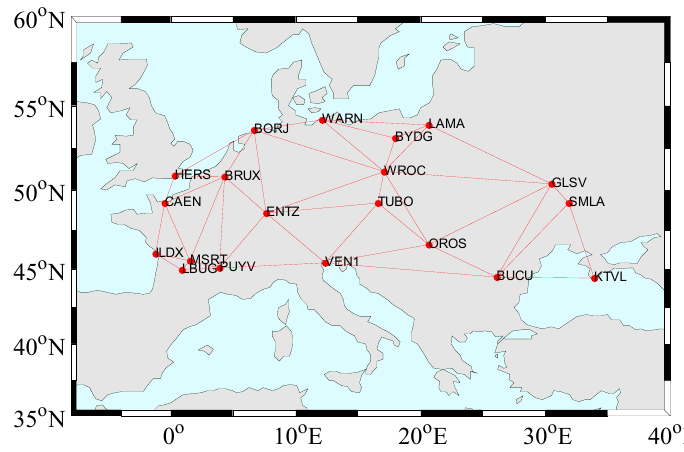
Figure 1. Distribution of the stations used and the baselines.